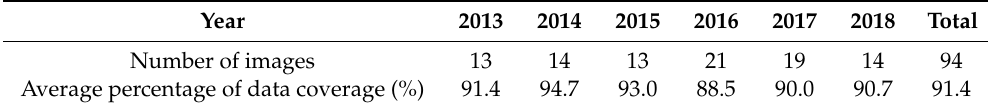
Table 2. Number of images used and average percentage of data coverage over the study area.